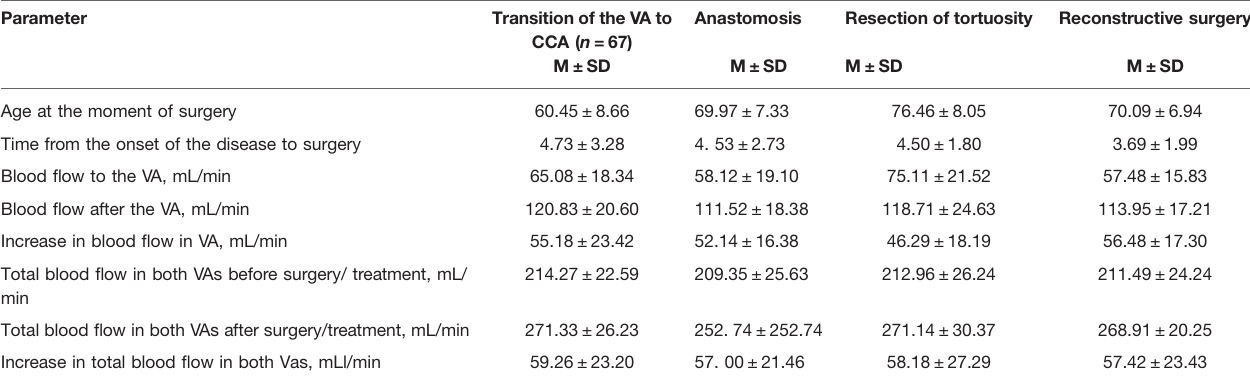
TABLE 3 | Characteristics of blood fl ow in the V1 segment of vertebral artery (VA). depending on the type of surgery